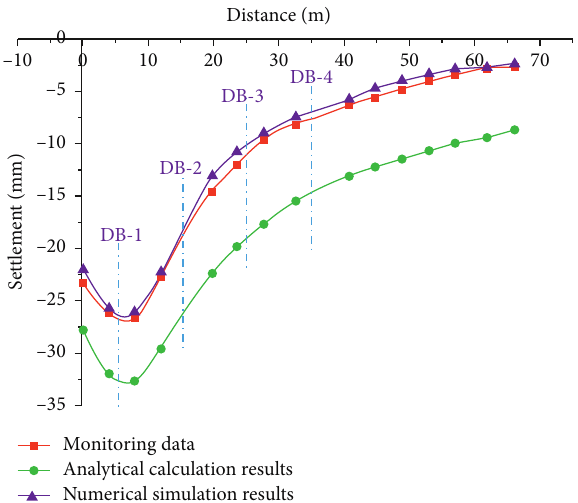
Figure 10: Comparison between different settlement values.